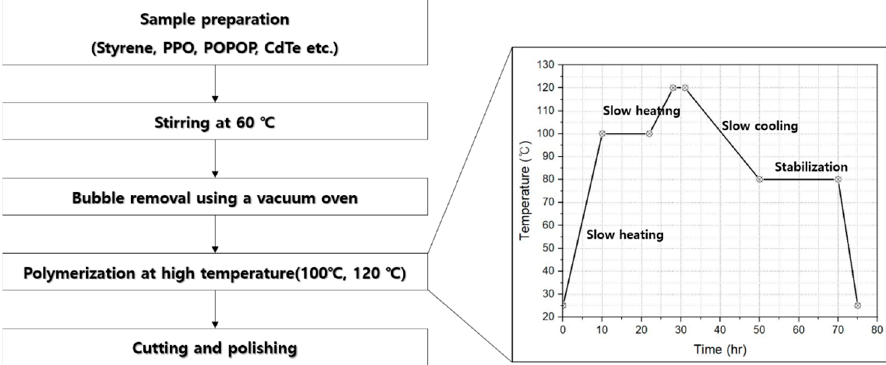
Figure 2. Manufacturing process of a functional plastic scintillator.